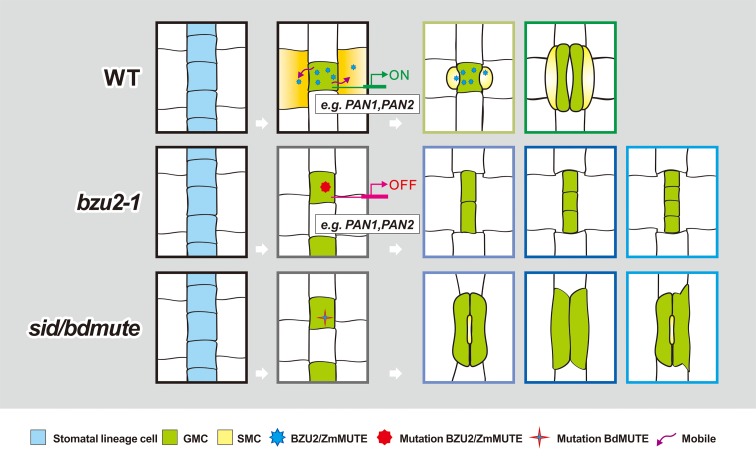
A schematic illustration of a plausible model of stomatal development modulated by BZU2/ZmMUTE.The bzu2-1 mutants show defects in the symmetrical division of GMCs, and also lack nuclear polarization and/or actin accumulation at the SMC/GMC interface. Defects in premitotic SMC polarization precludes the SMCs from forming SCs. SMC: subsidiary mother cell; GMC: guard mother cell; PC: pavement cell; sid: subsidiary cell identity defective.